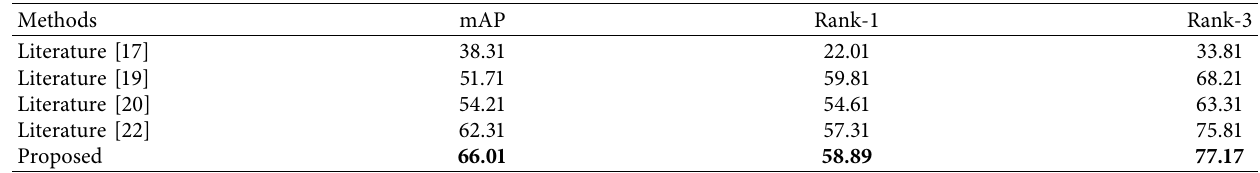
Table 2: The accuracy result on Duke datasets.